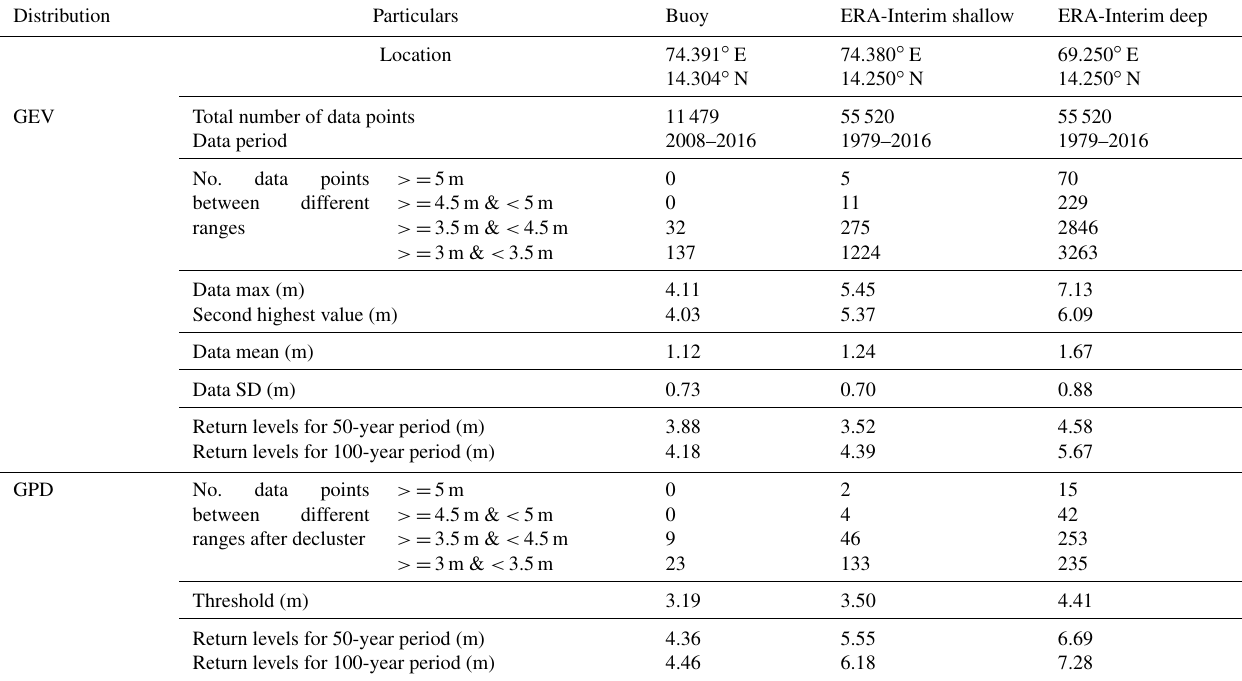
Table 1. The comparison of 50- and 100-year significant wave height return levels based on buoy, ERA-Interim shallow and ERA-Interim deep data at 6h intervals along with data statistical